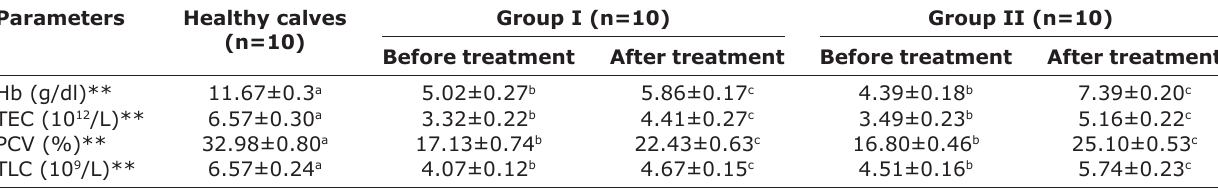
Table-2: Mean±SE value of hematological parameters in apparently healthy and bovine tropical theileriosis infected calves of Groups I and II (before and after treatment). Parameters